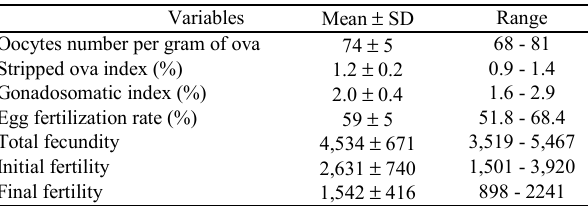
Table 2. Means of the oocytes number per gram of ova, stripped ova index, gonadosomatic index, fertilization rate, total fecundity, and initial and final fertility after induced spawning in females of Lophiosilurus alexandri (N =